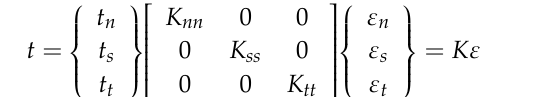
Figure 11. Schematic of three-dimensional eight-node interface element.